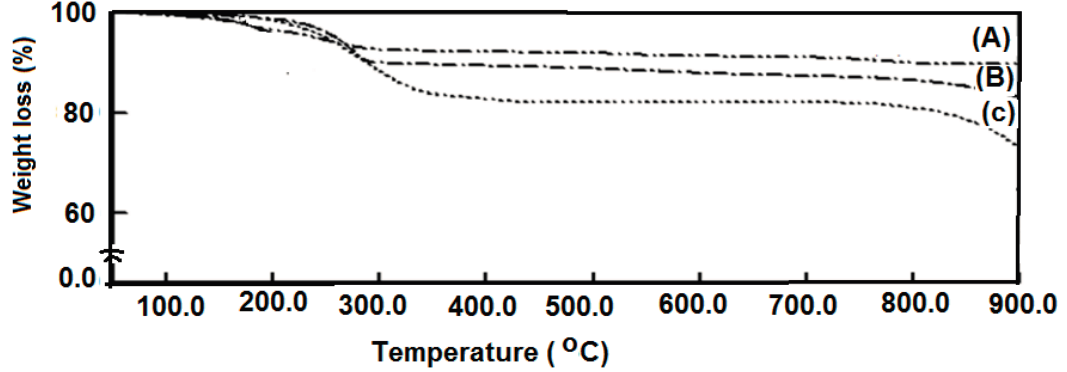
Figure 6. Thermogravimetric thermograms of (A) magnetite; (B) magnetite coated with RK/AN and (C) magnetite coated with R/AN